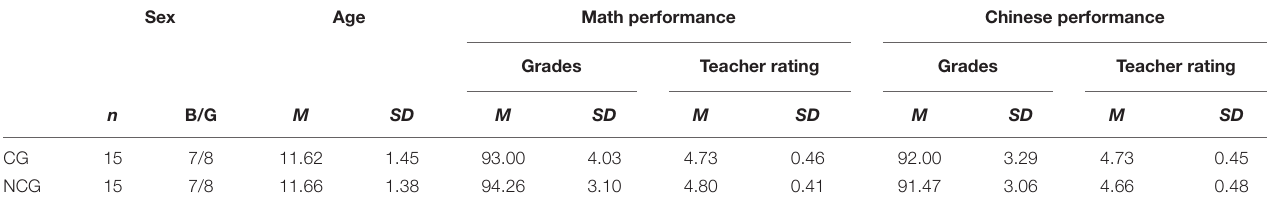
TABLE 1 | Participant